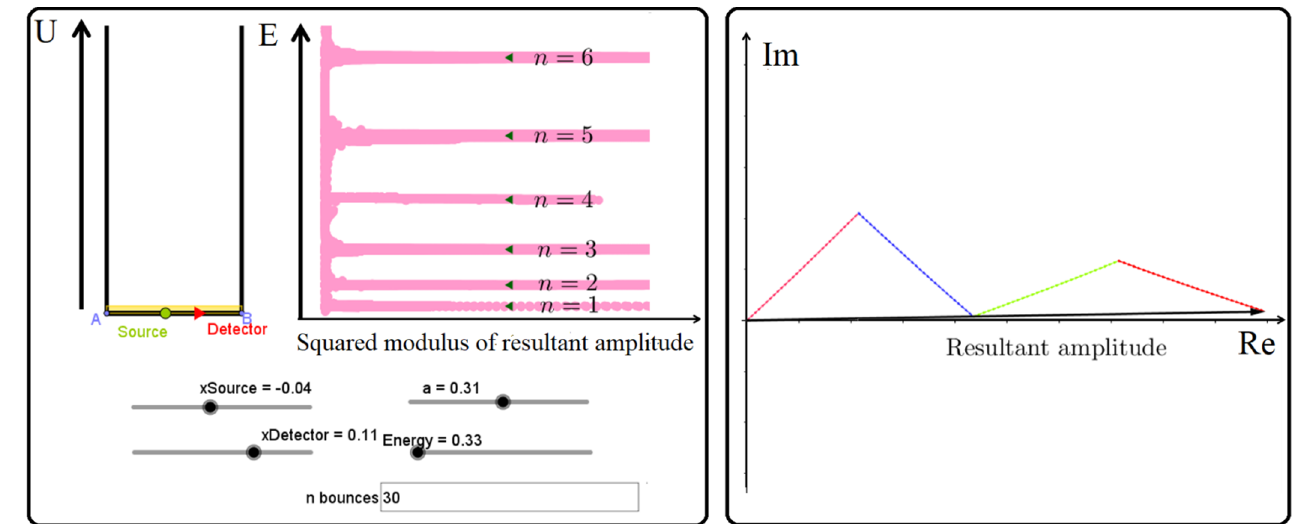
Figure 2. Partial snapshot of the simulation of the infinite square potential well. Left: a drawing of the potential, the initial and final points, and the numerically computed energy levels for n = 1 to 6. The sliders of the GeoGebra simulation are shown as grey lines with the input values shown by solid black circles. a is the halfwidth. In this particular case, the value of Energy corresponds to a stationary state (energy level) for the given value of a. The values of xSource and xDetector correspond to x i and x f in the text and in this case neither of them is placed on a wavefunction node, see below for details. Right: detail of the imaginary part vs. real part of the amplitude computation for